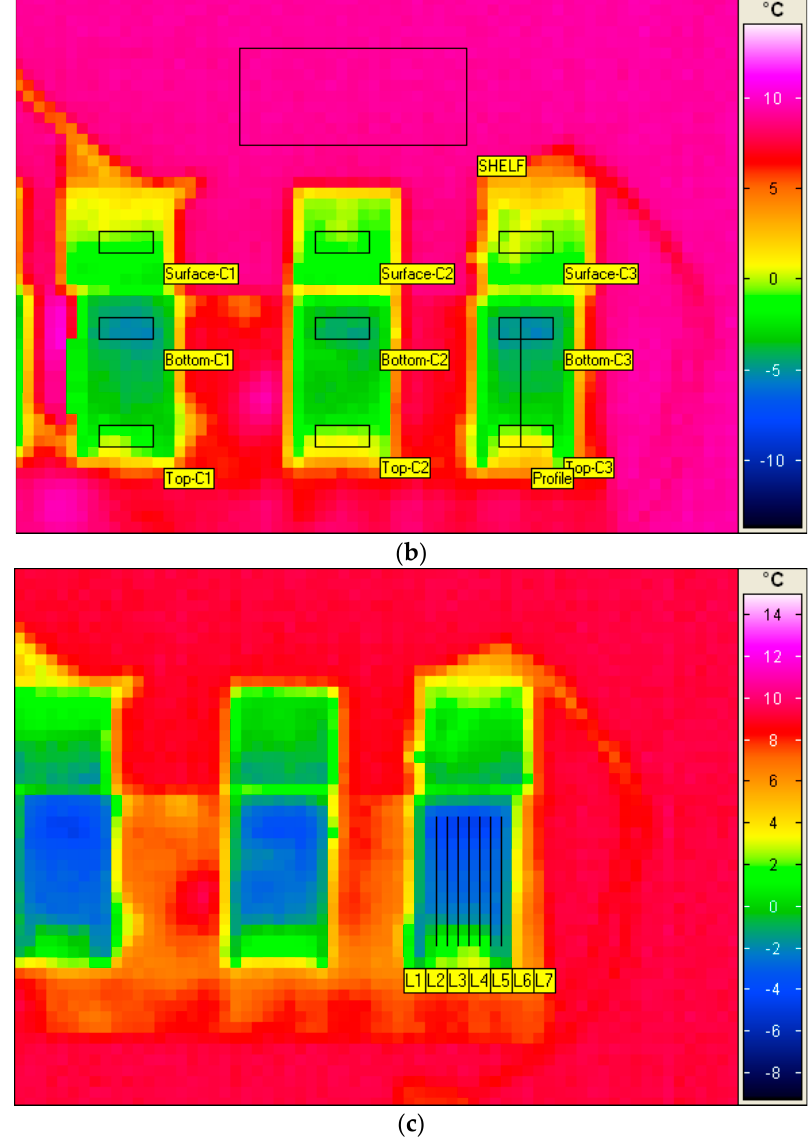
Figure 4. ( a ). Schematic overview to the left, IR camera (1), main Ge ‐ window in chamber ‐ wall of freeze ‐ dryer (2), (pieces 1 and 2 not drawn to scale), side of Ge ‐ cuvette with dashed line indicating Ge ‐ window (3), IR mirror (4) and freeze ‐ drying shelf (5). LWIR radiation recorded by IR camera (6). To the right, reflection in IR mirror as seen by IR camera (4). Direct view of surface of the material in Ge ‐ cuvette where the regular brick pattern is indicating dry material a. Reflection of side of Ge ‐ cuvette (3) where the bottom of the cuvette side is shown as a compressed brick pattern indicating still frozen material b. The top part of the reflection is showing regular brick pattern indicating dry material c. ( b ). Thermogram of three Ge ‐ cuvettes with nine monitoring zones and one depth profile (right). The nine monitoring zones cover 10 pixels each where each pixel is 2 × 2 mm on the measured object. The depth profile covers 12 pixels or 24 mm. Temperatures of all time profiles shown in Figures 6 and 7a–d were monitored using this profile. Monitoring of shelf temperature was performed inside the large rectangle of 198 pixels at the top (SHELF). ( c ). Seven depth profiles used to create spatial contour plots of Ge ‐ window shown in Figure 8a–i. The lines are covering 24 × 14 mm obtaining temperature data from 84 IR pixels. The rims of the cuvettes are clearly visible and were not monitored.